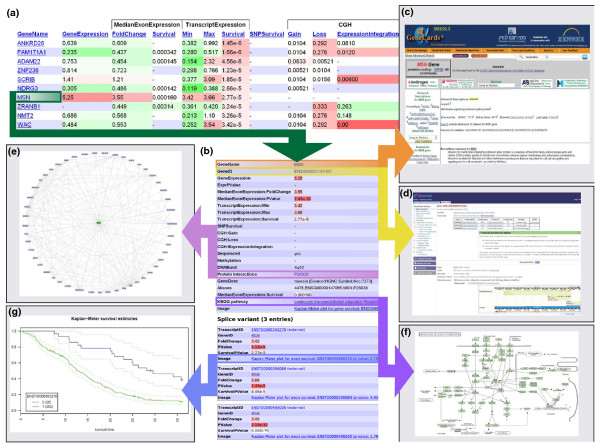
Example of Anduril-generated result website and links to external sources. Anduril generates a browsable website based on analysis results. (a) A screenshot of the gene level view of the data. The genes are sorted according to the survival P-value on the exon platform. The data are divided into 13 fields corresponding to analysis results and data sources. For example, the field 'GeneExpression' illustrates fold changes between GBM and control samples using data from gene expression microarrays. Exon array values are computed at the gene ('MedianExonExpression') and transcript levels ('TranscriptExpression'). For the transcript data the minimum and maximum transcript expression values show GBM-specific alternative splice variant candidates. The fields 'TranscriptExpression:Survival' and 'MedianExonExpression:Survival' show survival analysis P-values for the best transcript and gene in the exon arrays, whereas 'SNPSurvival' contains P-values for the survival associated SNPs. The green color for 'GeneExpression', 'FoldChange', 'Min', 'Max', 'Gain', 'Loss' and 'Methylation' denote downregulation and red denotes upregulation. The red color for P-values for the fields 'Survival', 'SNPSurvival' and 'ExonIntegration' denotes low P-values. (b) A web page that opens after clicking the gene MSN. This page contains detailed results and external links. (c, d) Clicking 'GeneName' opens a website in Genecards [28] (c), and 'GeneID' connects to Ensembl [29] (d). (e) Clicking 'Protein Interactions' opens a page listing known protein-protein interactions in PINA [27]. (f) Clicking an entry in 'KEGG pathway' allows accessing pathways at the KEGG [26] website. (g) Each splice variant is listed separately and if the survival P-value is < 0.01, the users can view the Kaplan-Meier curves. The groups '1', '-1' and '0' denote overexpression, underexpression (not shown for MSN) and stable expression, respectively ('-1' is not present in the figure). The dotted lines are 95% confidence intervals.